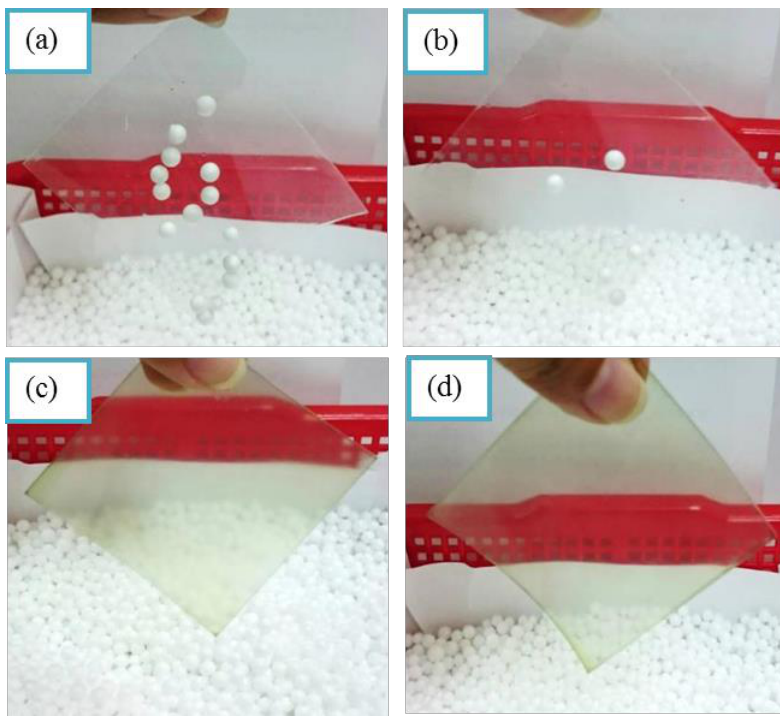
Figure 9. Photograph of antistatic comparison: ( a ) pure PET sheet; ( b ) pure UV coating film; ( c ) UV coating/5 wt% PANDB; and ( d ) UV coating/10 wt% PANDB conductive composite films.